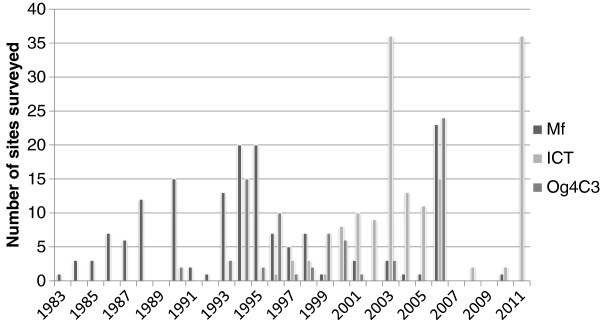
Number of individual survey sites by year, classified by assay type.